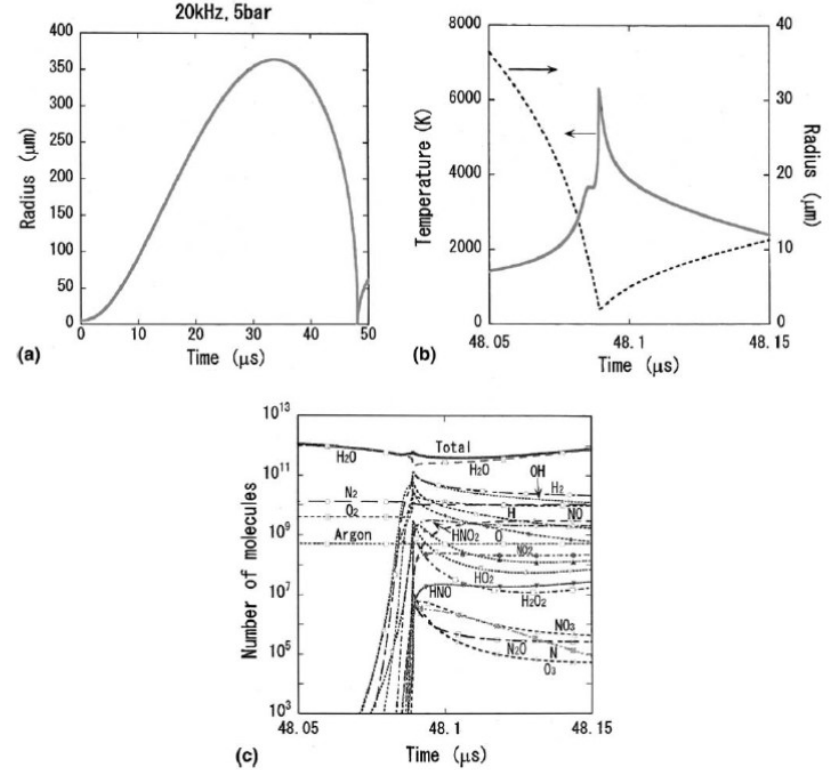
Figure 8. Calculated results for an air bubble in liquid water at 20 ◦ C irradiated by an ultrasonic wave of 20 kHz and 5 bar in frequency and pressure amplitude, respectively [33]. The ambient bubble radius is 5 µ m. ( a ) The radius-time curve for one acoustic cycle. A bubble disintegrates into daughter bubbles by shape instability at t = 152.7 µ s which is out of this figure. ( b ) The temperature inside a bubble and the bubble radius as a function of time at around the end of the bubble collapse only for 0.1 µ s. ( c ) Numbers of molecules of various species inside a bubble as a function of time with the same time axis as that of ( b ). The vertical axis is in logarithmic scale. Copyright 2005, with the permission from Elsevier.